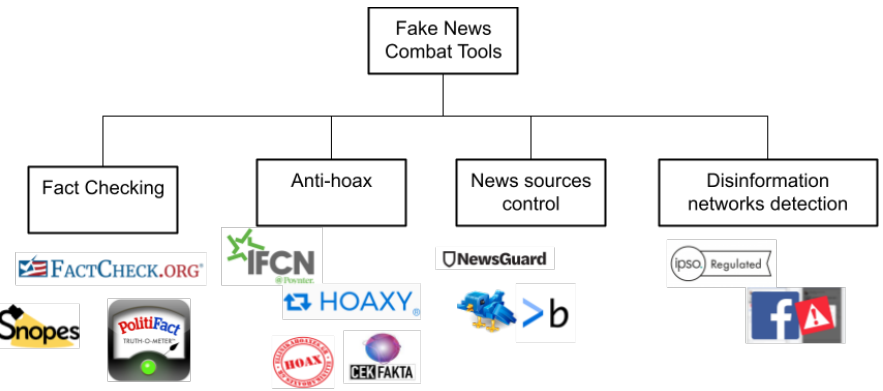
Figure 1. An overview of the various tools that combat fake news and